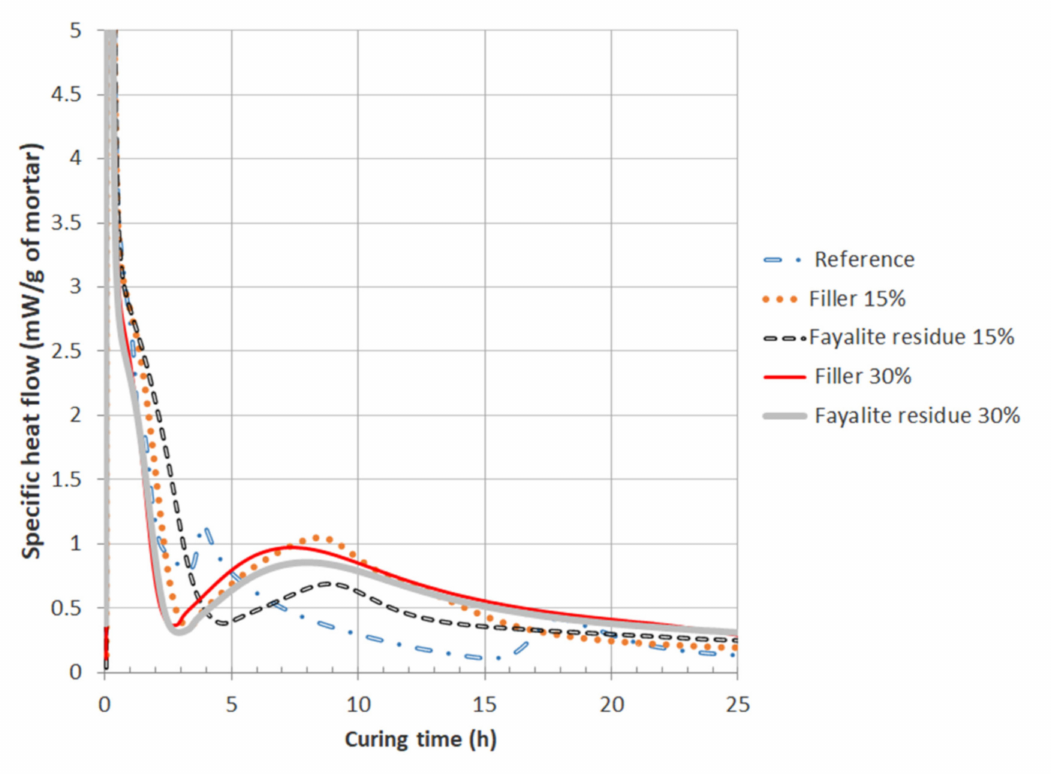
Figure 5. Specific hydration heat flow for mortars containing copper slag leach residue as 15% or 30% replacement of CAC in comparison to reference mortars and mortars containing a filler.